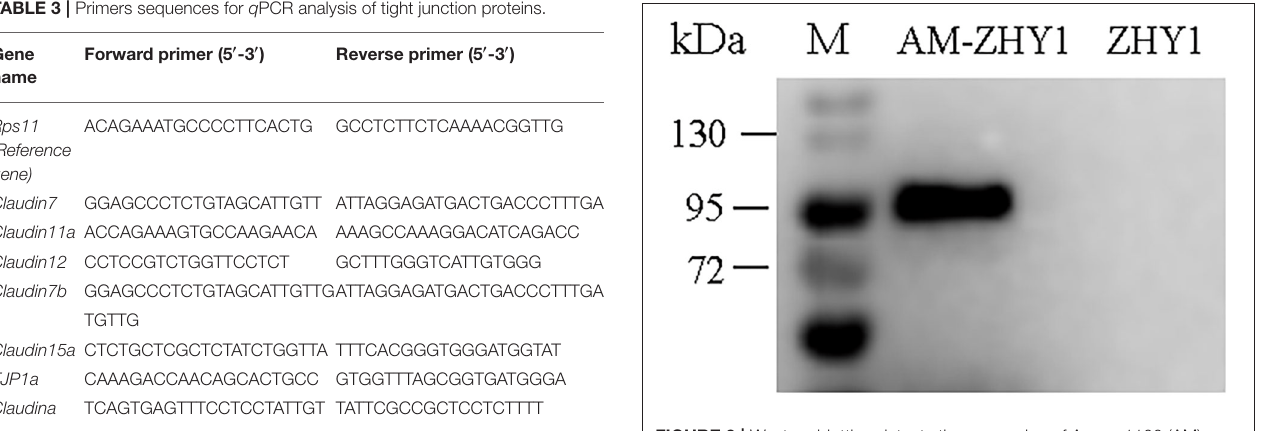
FIGURE 2 | Western blotting detects the expression of Amuc_1100 (AM) on ZHY1. Line 1: protein marker (26630, Thermo Scientific), line 2: the whole cell wall protein of recombinant strain AM-ZHY1, line 3: the whole cell wall protein of control strain